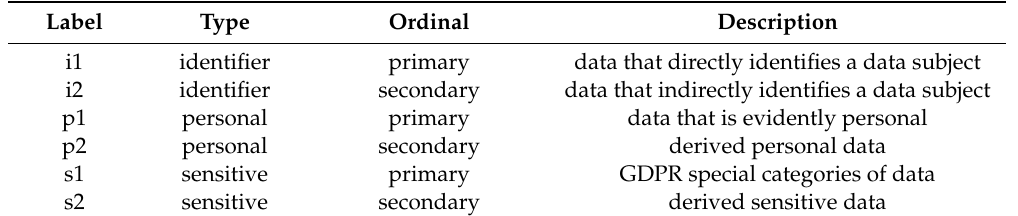
Table 1. Personal data types.